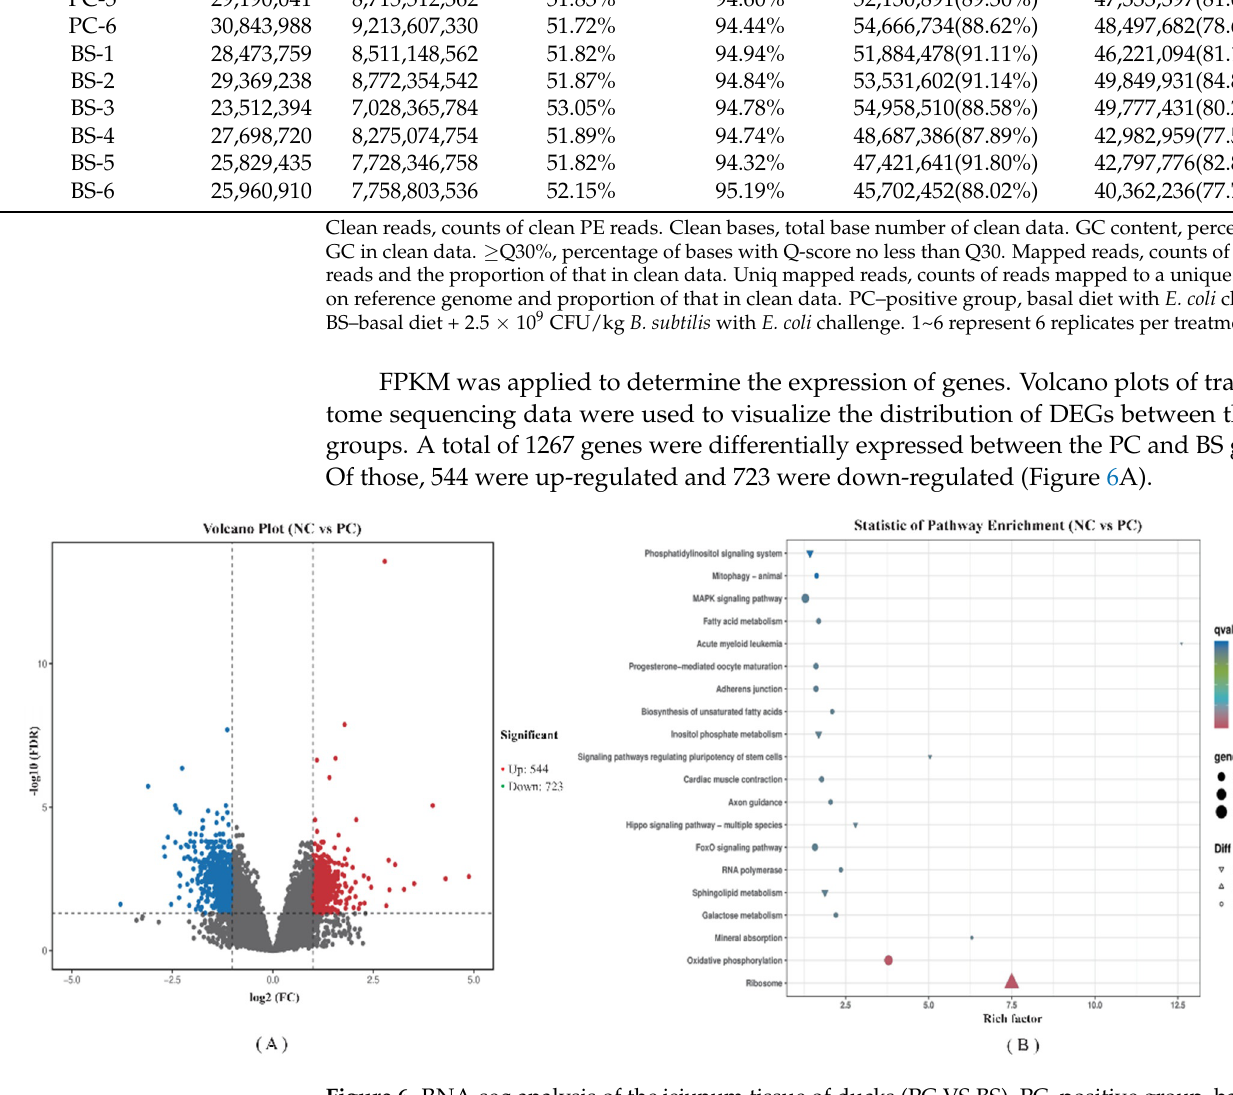
Figure 6. RNA-seq analysis of the jejunum tissue of ducks (PC VS BS). PC–positive group, basal diet with E. coli challenge. BS–basal diet + 2.5 × 10 9 CFU/kg B. subtilis with E. coli challenge. ( A ) Volcano plot of differentially expressed genes. X-axis shows log2 (FC) of DEGs between each two groups, Y-axis represents the statistically significant negative logarithm value of the gene expression change; Each point in the volcanic map represents a gene, Red represents increased expression while green represents decreased expression; ( B ) Dot plot of KEGG pathway enrichment analyses of differentially expressed genes.